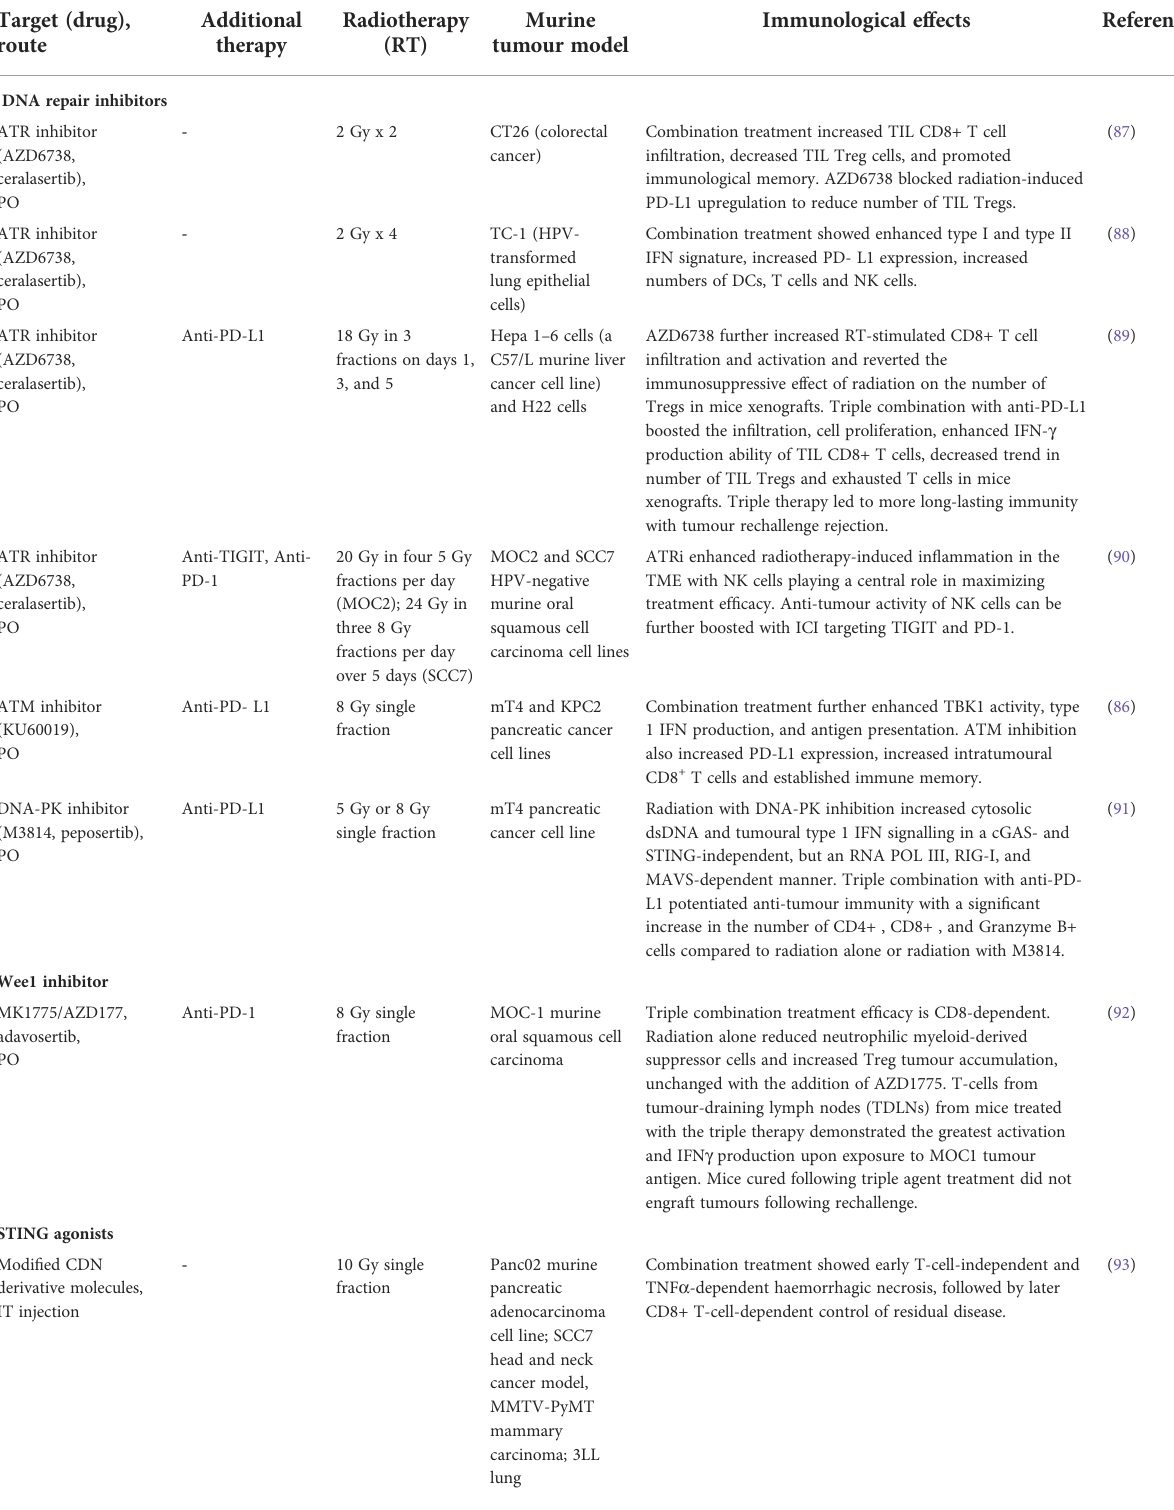
TABLE 1 Preclinical RT and DDR combination studies. Target (drug),